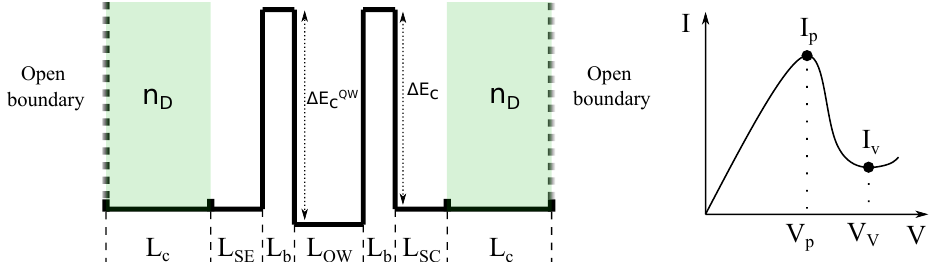
Figure 1. Scheme of the potential profile of the two-barrier resonant tunneling nanostructure and the characteristic dependence of the current on the applied voltage for such a structure. Strongly doped contact layers with donor concentration n D and thickness L c are indicated in green; I p and V p are the peak current and peak voltage; I v and V V are the valley current and valley voltage. L SE —thickness of emitter spacer layer; L SC —thickness of collector spacer layer; L b —thickness of barrier layer; L QW —thickness of quantum well; ∆ E c and ∆ E QW c —conduction band discontinuities between layers with different band